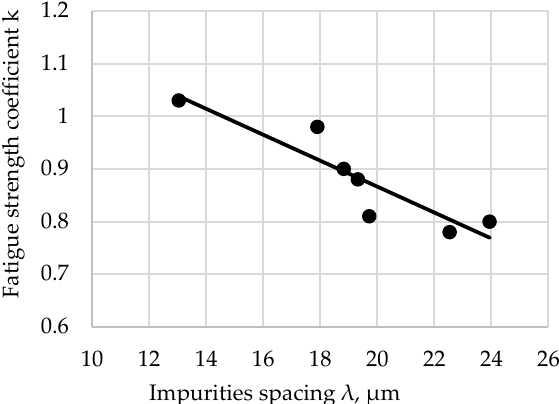
200 ◦ C depends on the impurities spacing λ . at 200 °C depends on the impurities spacing λ.